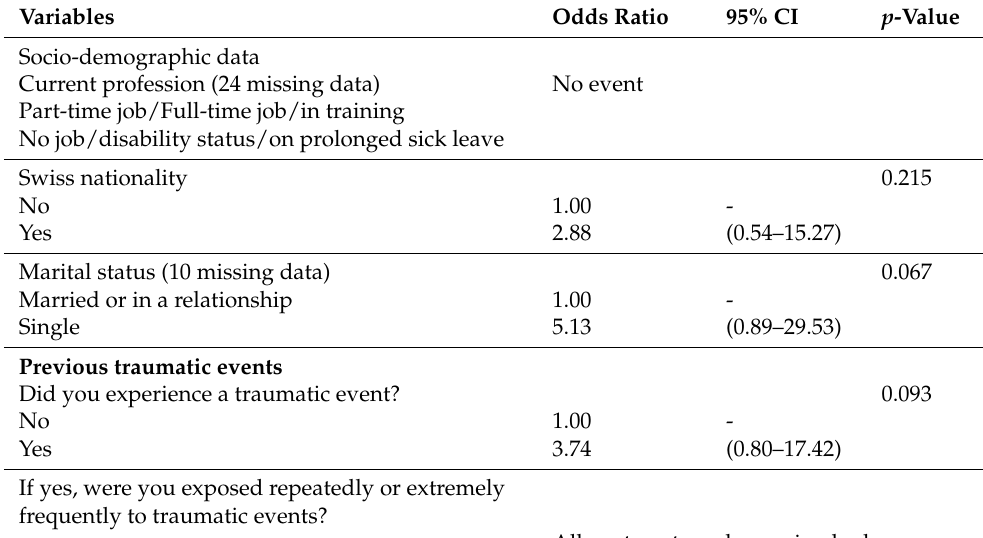
Table 11. Variables associated with post-partum depression according to DSM-5 (measures of associations, univariate